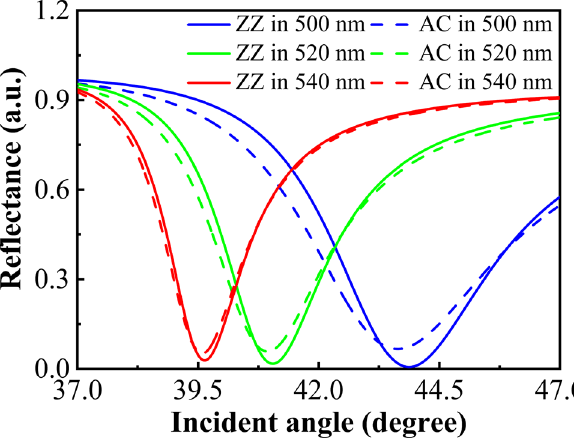
Figure 7: Shifts of the resonance angles when the polarization changes from zigzag (ZZ) to armchair